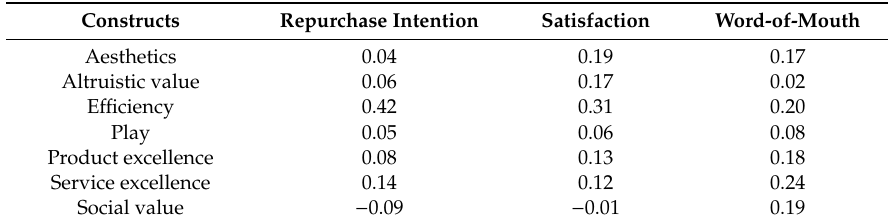
Table 7. Path coe ffi cients.